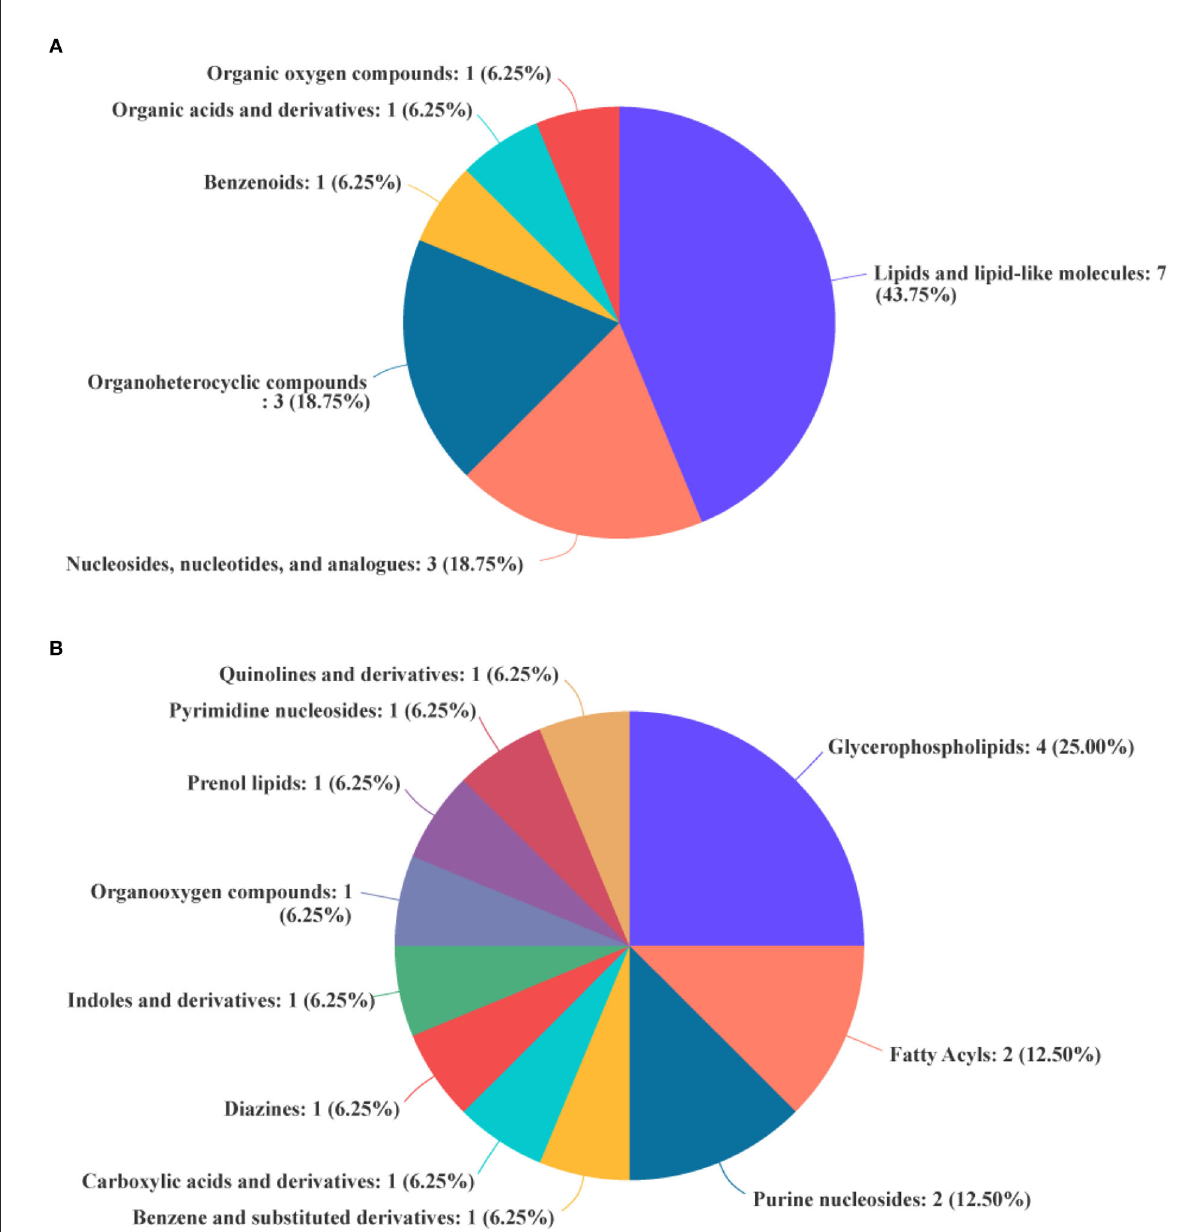
FIGURE6 Biochemical categories of the differential metabolites identified between the experimental group (VB3) and control group (Control). (A) Superclass. (B) Class.